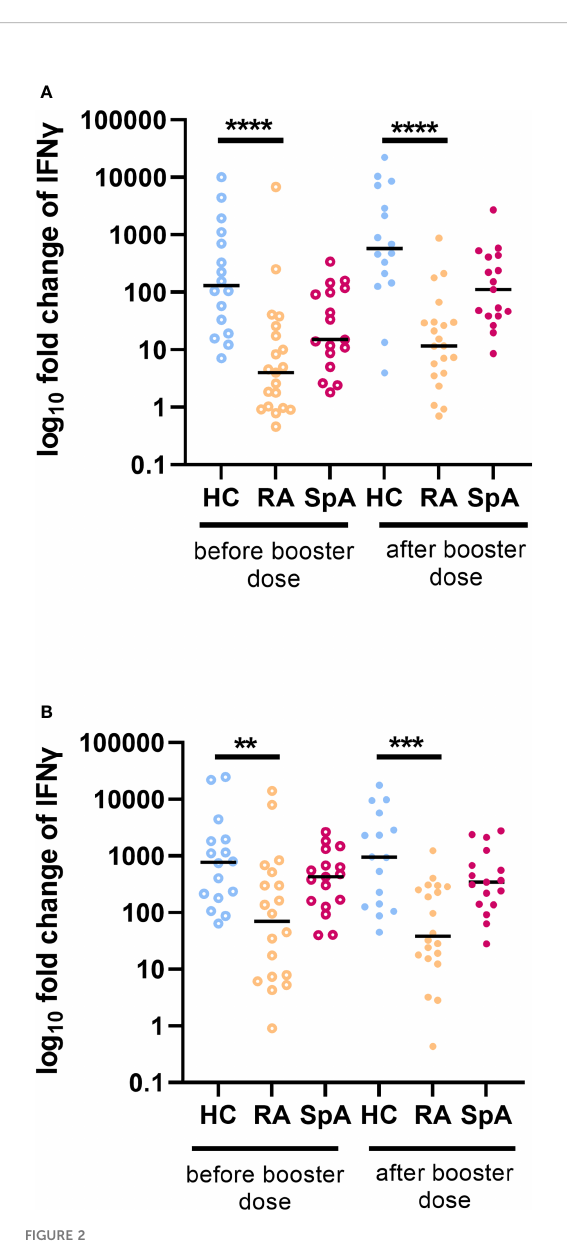
FIGURE 2 Fold change of INF- g production after (A) viral protein and (B) mitogen stimulation in patients with rheumatoid arthritis (RA; n=20) and spondyloarthritis (SpA; n=25) compared to healthy controls (HC; n=20) before and after a booster dose of COVID- 19 vaccine. In the group comparison, the Kruskal – Wallis test with post hoc analysis with the Dunn ’ s test was performed. Dots represent individual values and the line represents the median. A p values were expressed as follows: 0.01>p>0.001 as**; p<0.001 as***; p<0.0001